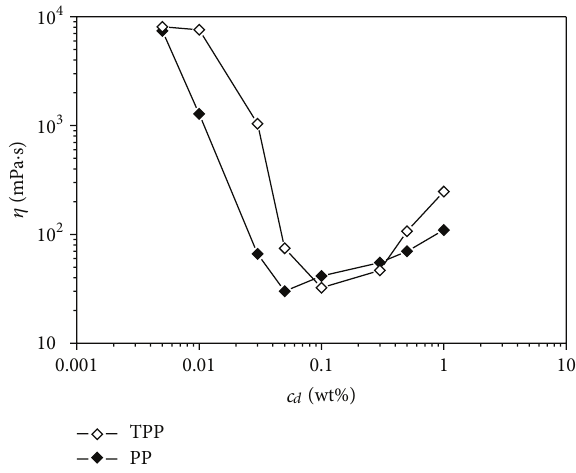
Figure 3: Apparent viscosity ( 𝜂 ) versus deflocculant concentration ( 𝑐 𝑑 ) for 77.5 wt% alumina suspension as function of the dispersant nature ( ̇𝛾 = 200 s −1